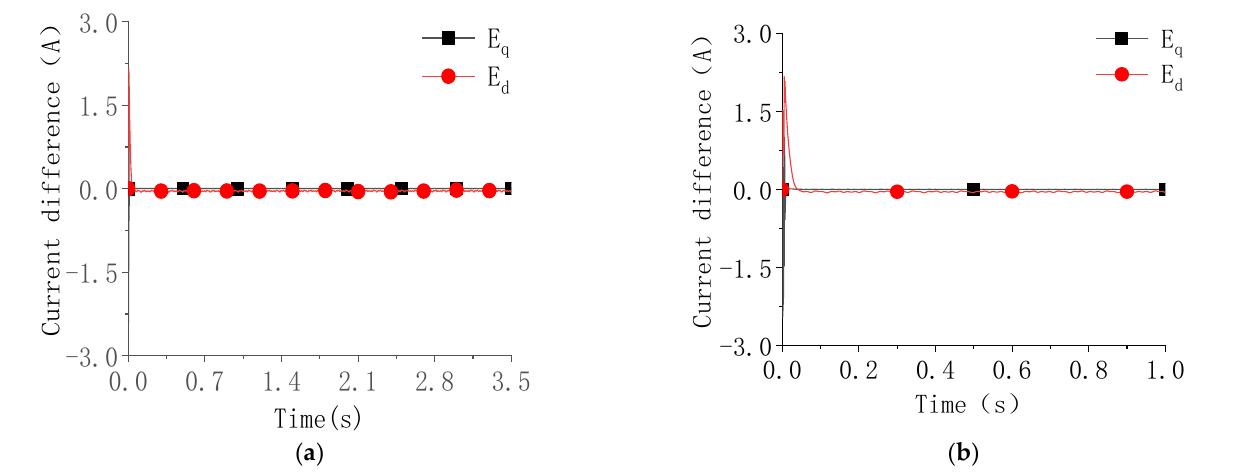
Figure 9. Difference between the stator current identification value and the actual value. ( a ) Stator current identification difference and ( b ) the local magnification of the anterior segment.